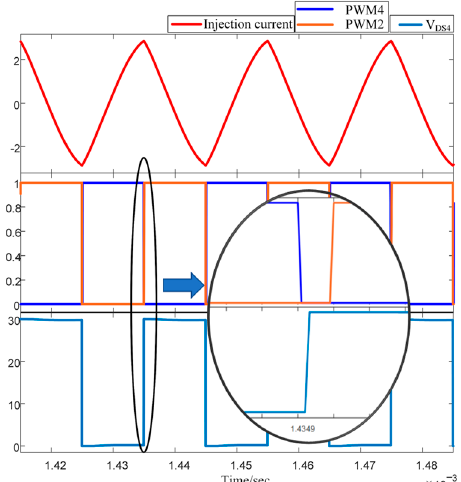
Figure 8. Main waveforms with auxiliary current source. ( a ) Load voltage and current waveform; ( b ) Q 1 Q 3 trigger signal and Q 1 drain-source voltage waveform; ( c ) Voltage waveform of the auxiliary capacitor and the auxiliary current source injection current waveform; ( d ) Q 2 Q 4 trigger signal and Q 4 drain-source voltage waveform.